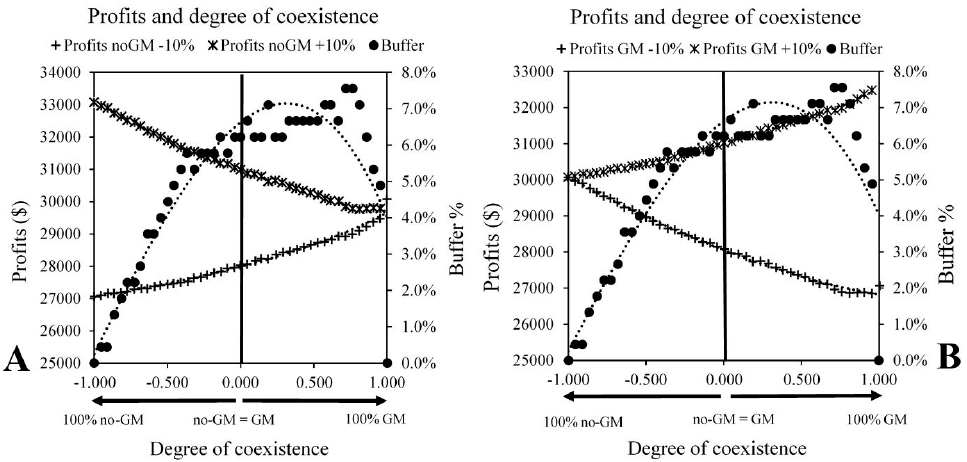
Figure 2. Amount of buffer and landscape profit for +10% and − 10% non-GM per acre profitability compared to GM when GM has the property rights ( A ) and for +10% and − 10% GM per acre profitability compared to non-GM when non-GM has the property rights ( B ).